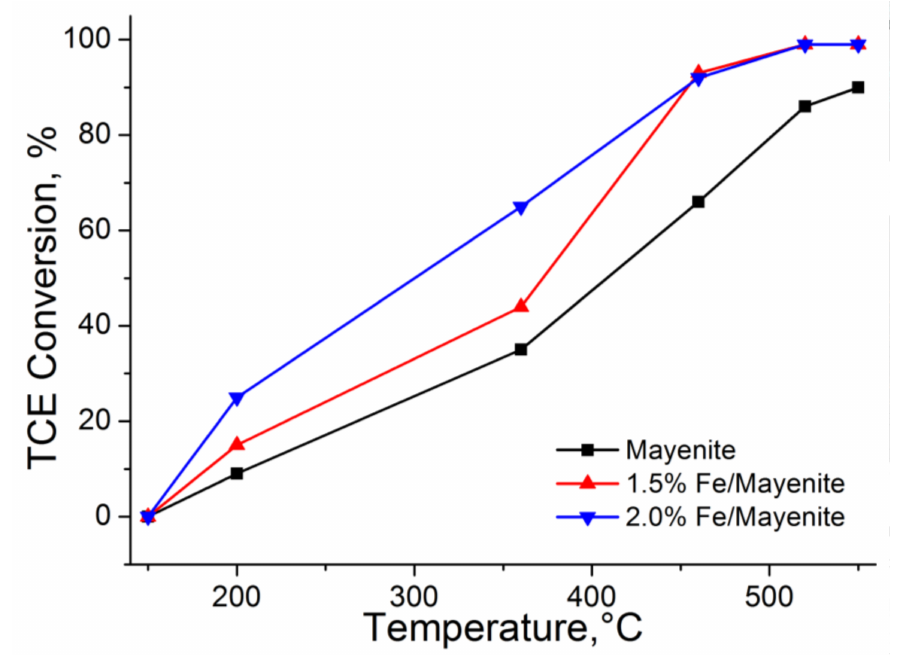
Figure4. TCEconversioninwetconditionsformayenite(black), 1.5%(red), and2.0%(blue)Fe /